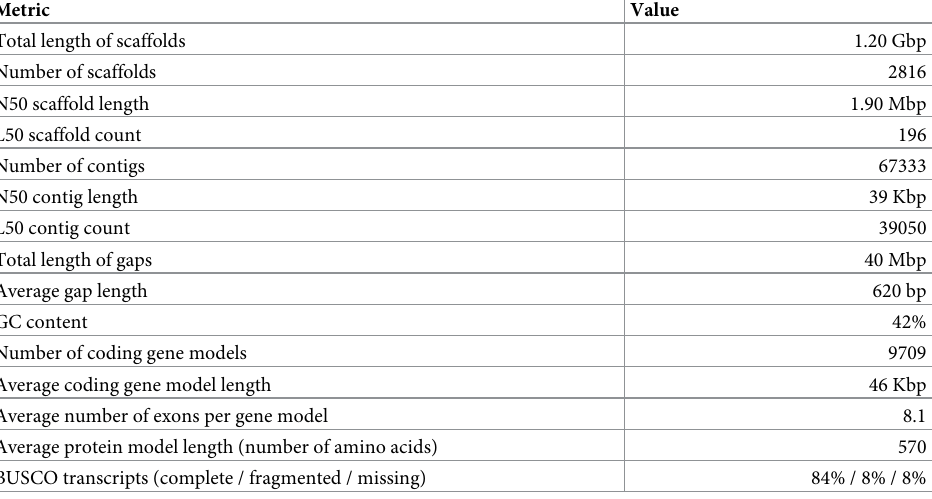
Table 1. Fasciola hepatica assembly